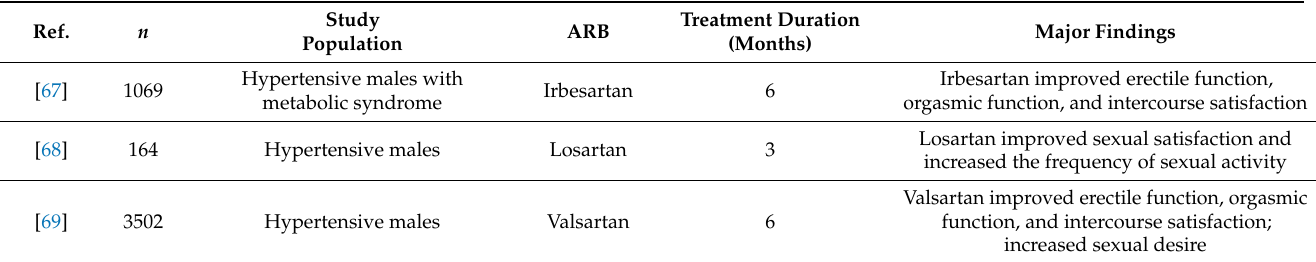
Principal findings of major clinical studies that evaluated the effect of ARBs on erectile